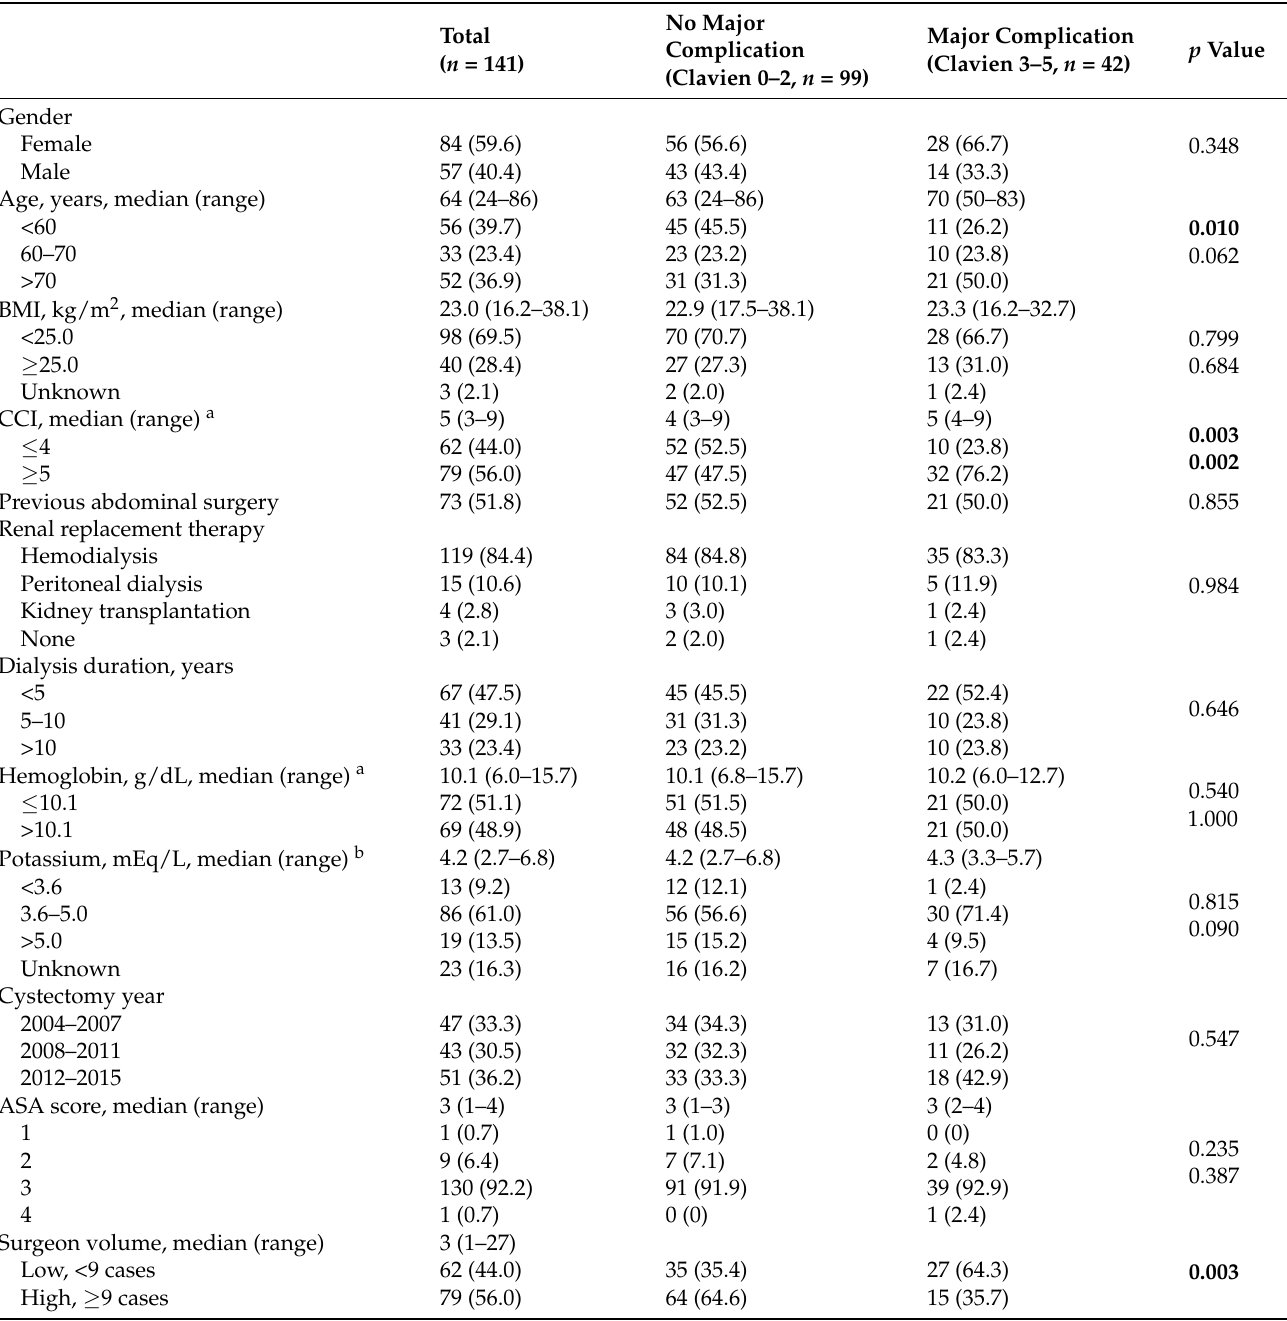
Table 1. Clinical characteristics of dialysis patients undergoing radical